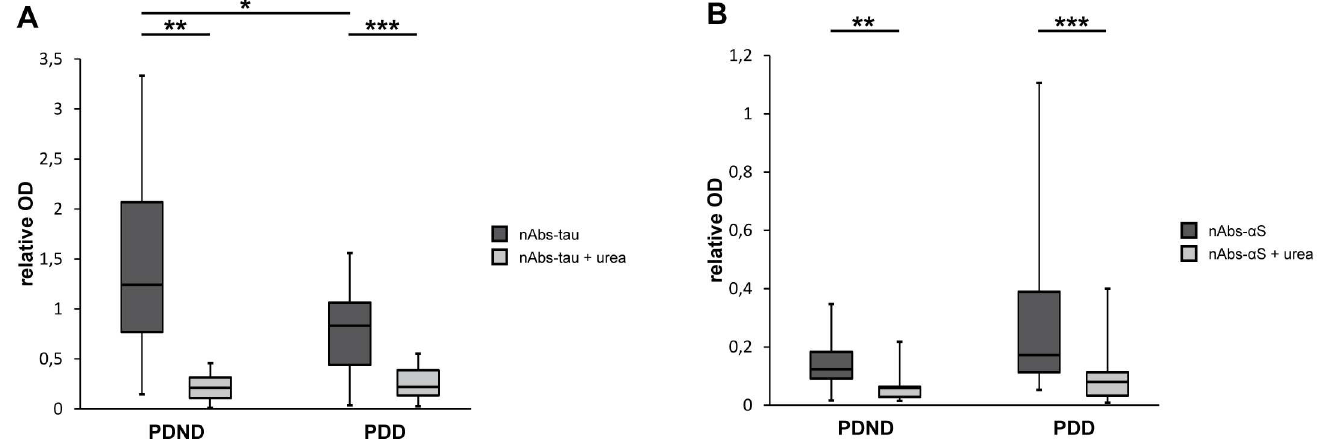
Fig 2. Distribution of relative serum sample ODs of nAbs-tau- (A) and nAbs- α S-ELISA (B). The relative serum sample OD (related to serum standard OD) of each non-demented (PDND) and demented Parkinson’s disease (PDD) patient was determinedwithout (nAbs) and with urea treatment (nAbs + urea). For an overviewof their distribution, box plots show the median, 25% and 75% quartile. 50% of the generated data are located in the box and whiskers represent the minimum and maximum value. NAbs-tau OD showed significant differences between PDND and PDD patients (A; ** p = 0.007). Treatment with 8 M urea caused significant reduction of ODs of nAbs-tau (A; PDND: *** p = 0.002; PDD: *** p < 0.001) and nAbs- α S (B; PDND: * p = 0.001; PDD: ** p <